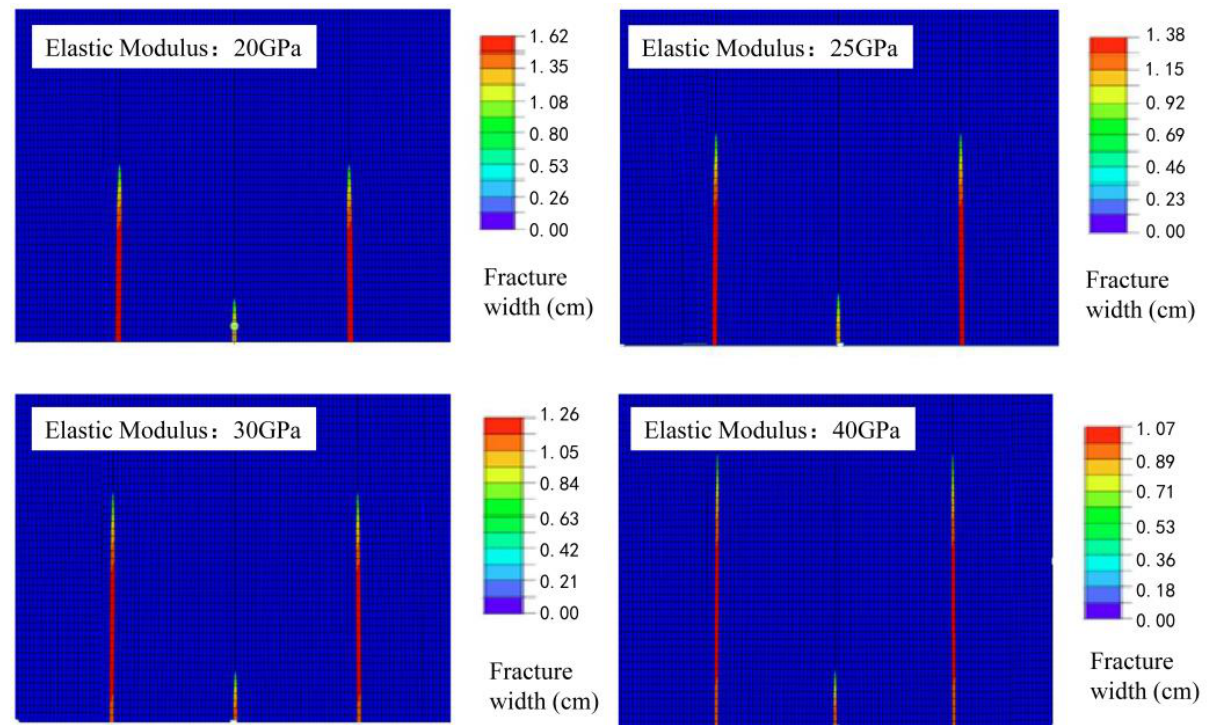
Figure 5: Contour of fracture morphology after fracturing for 10 minutes for formation with different elastic modulus. (Deformation scale factor = 500).